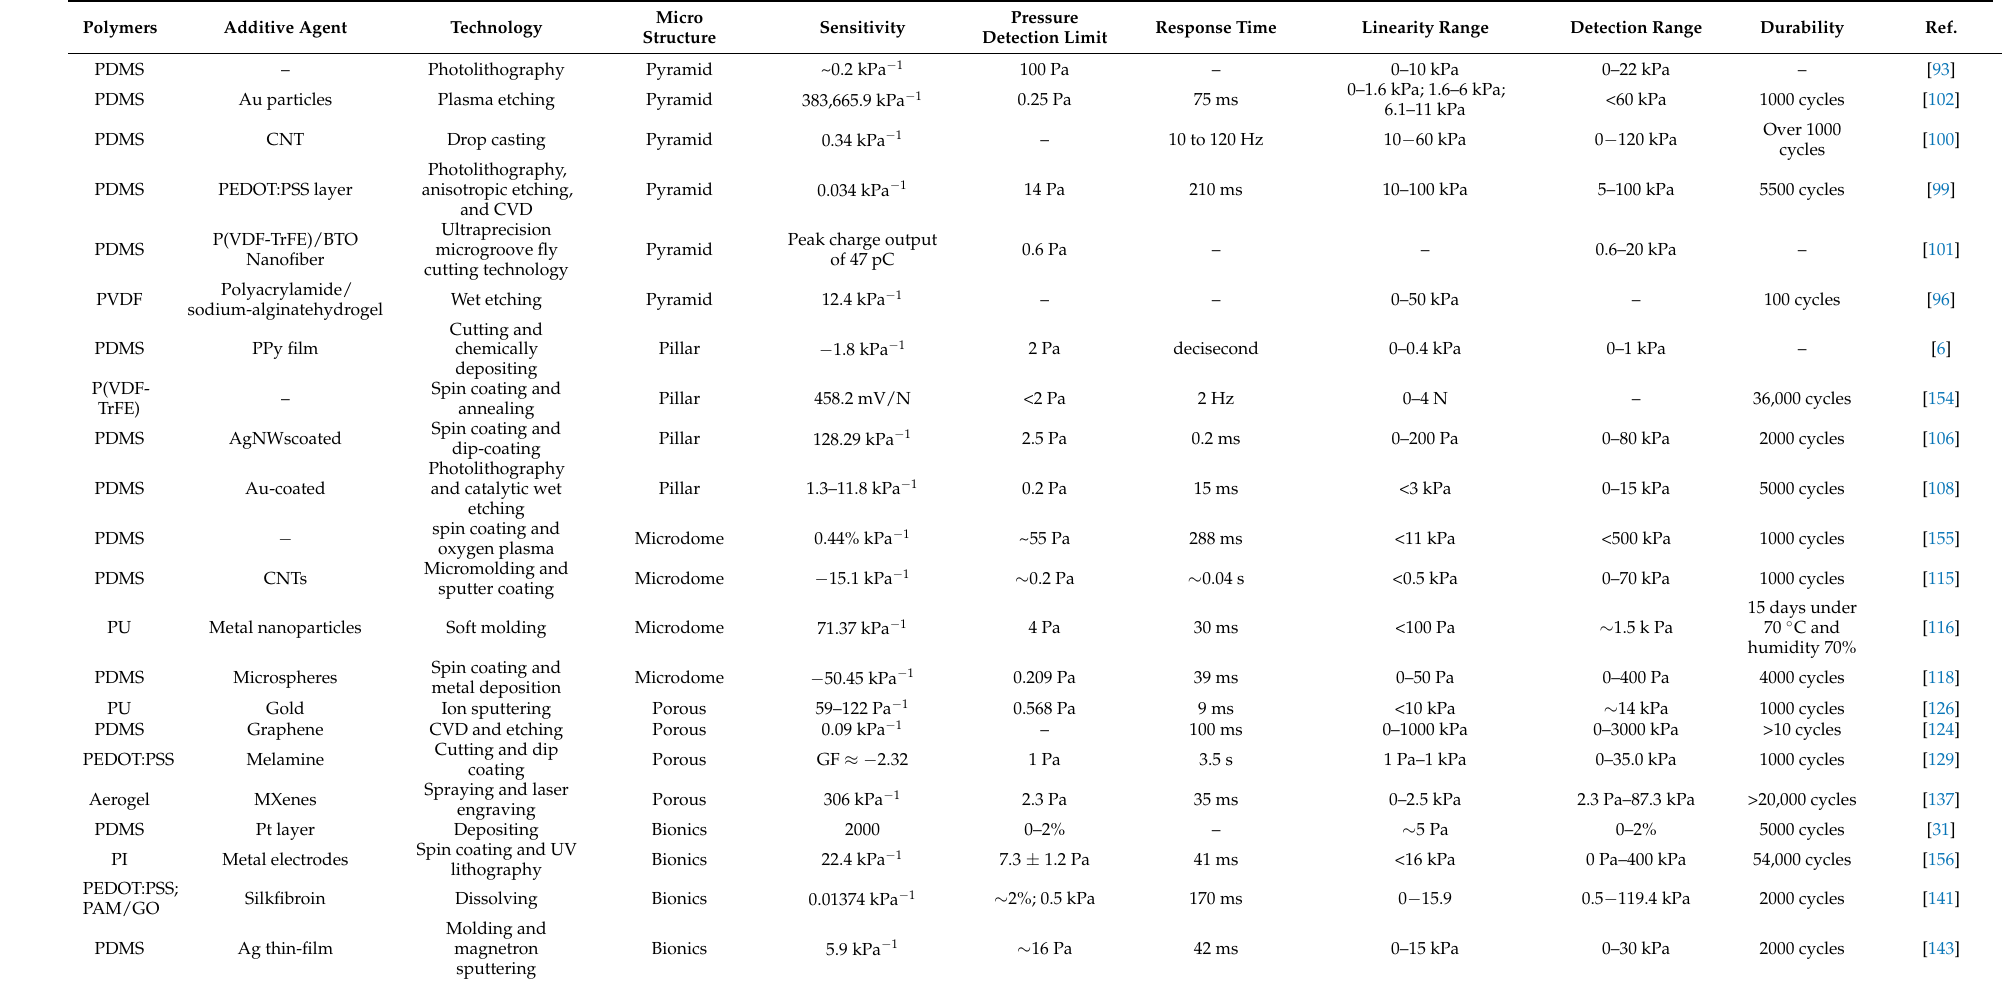
Table 1. Summary of main evaluation parameters of polymer-based flexible pressure sensors with different